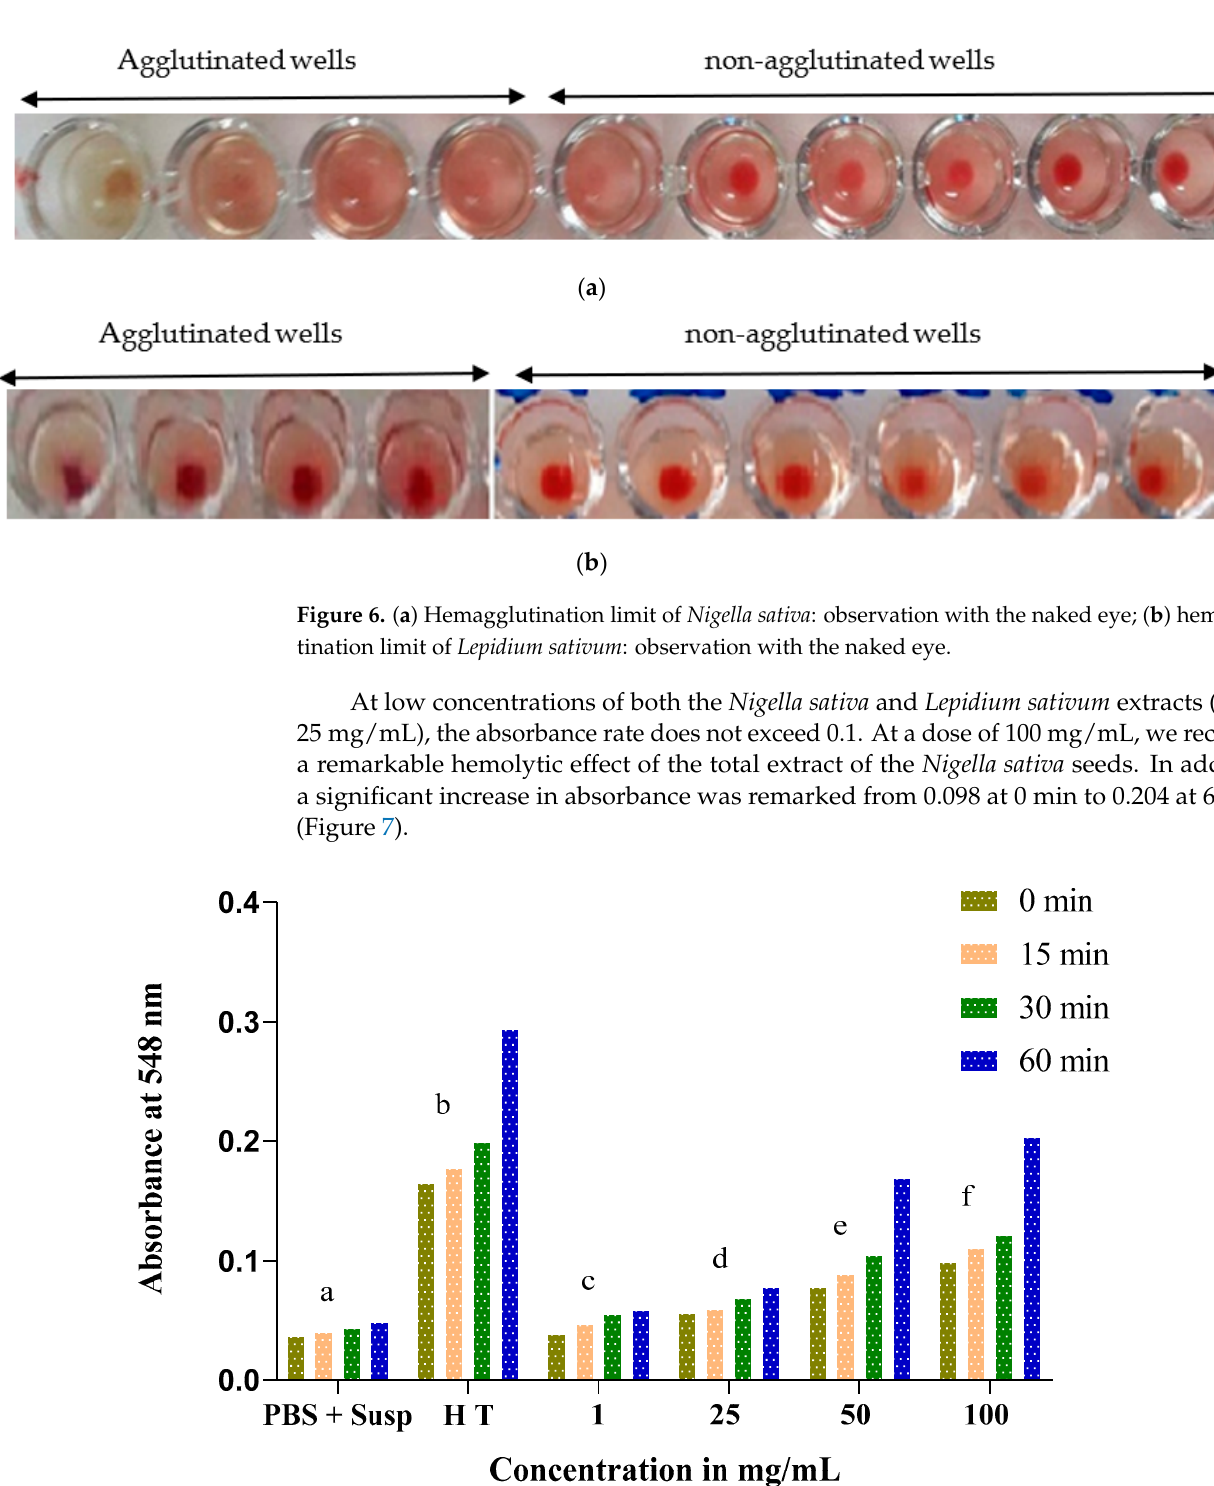
Figure 7. Time course of absorbance of tubes containing an erythrocyte suspension in the presence of different concentrations of total Nigella sativa extract incubated at 37 ◦ C compared to total hemolysis (H T) and negative control (PBS + Susp.). The same letters (a, b, c, d, e, f) denote a significant difference with respect to the absorbance.